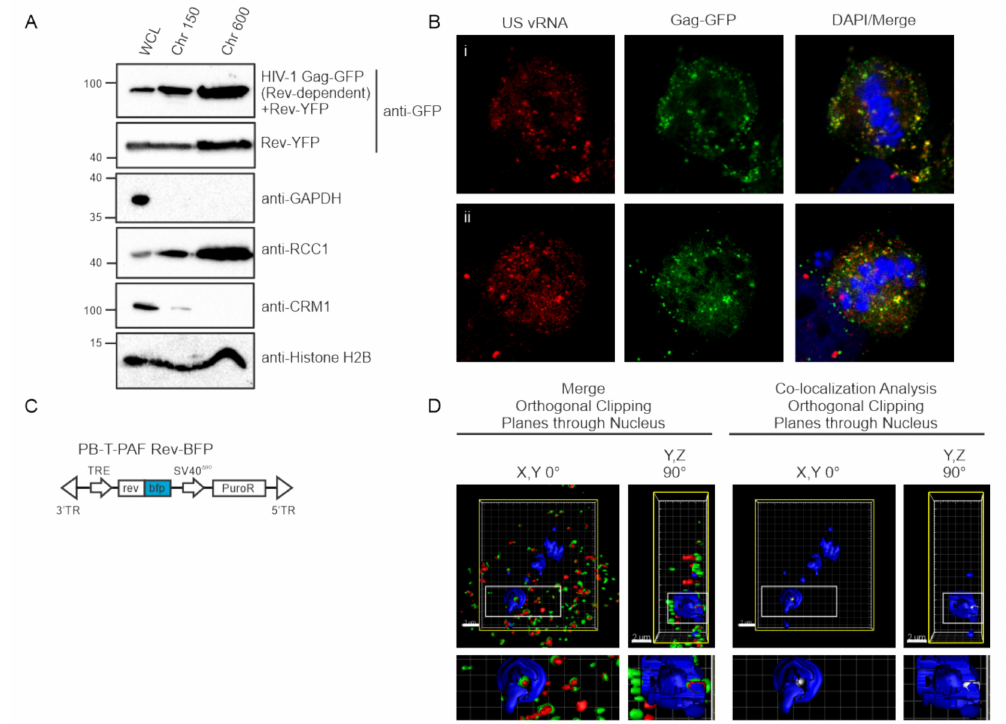
Figure 7. HIV-1 Gag and Rev are both present in chromatin-associated fractions and are co-localized in three dimensions. ( A ) 293T cells transfected with HIV-1 Gag-GFP with or without Rev-YFP expression plasmids were separated into chromatin-associated protein fractions representing euchromatin (Chr 150) and heterochromatin (Chr 600) and analyzed by immunoblotting using anti-GFP antibodies. Fraction purity was assessed by immunoblotting with antibodies to detect GAPDH (present only in whole cell lysate, WCL), CRM1 (WCL and chromatin), RCC1 (WCL and chromatin) and Histone H2B (WCL and